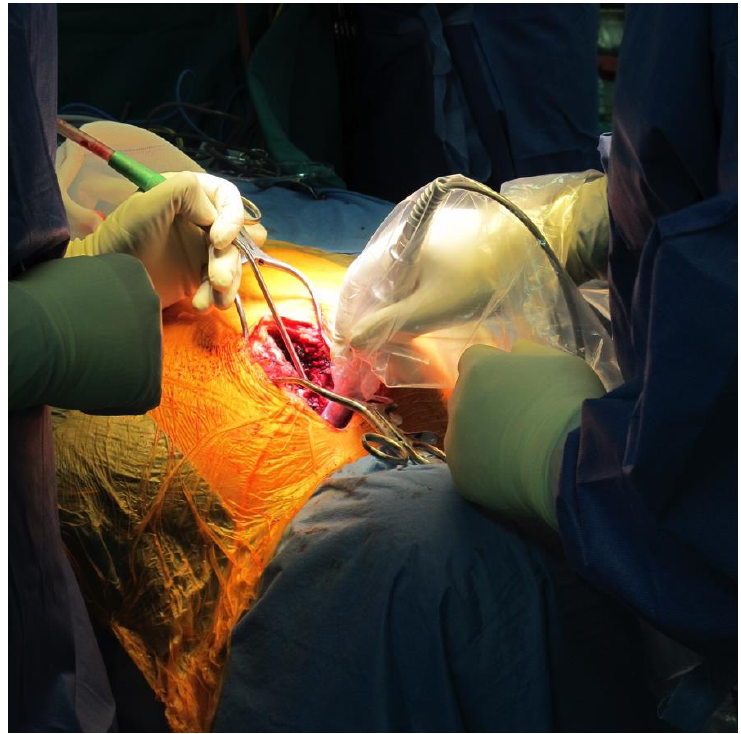
Figure 2. Intraoperative gamma-probe was used to localize the lesion; it can be used to ensure removal of all of the pathologic tissue.